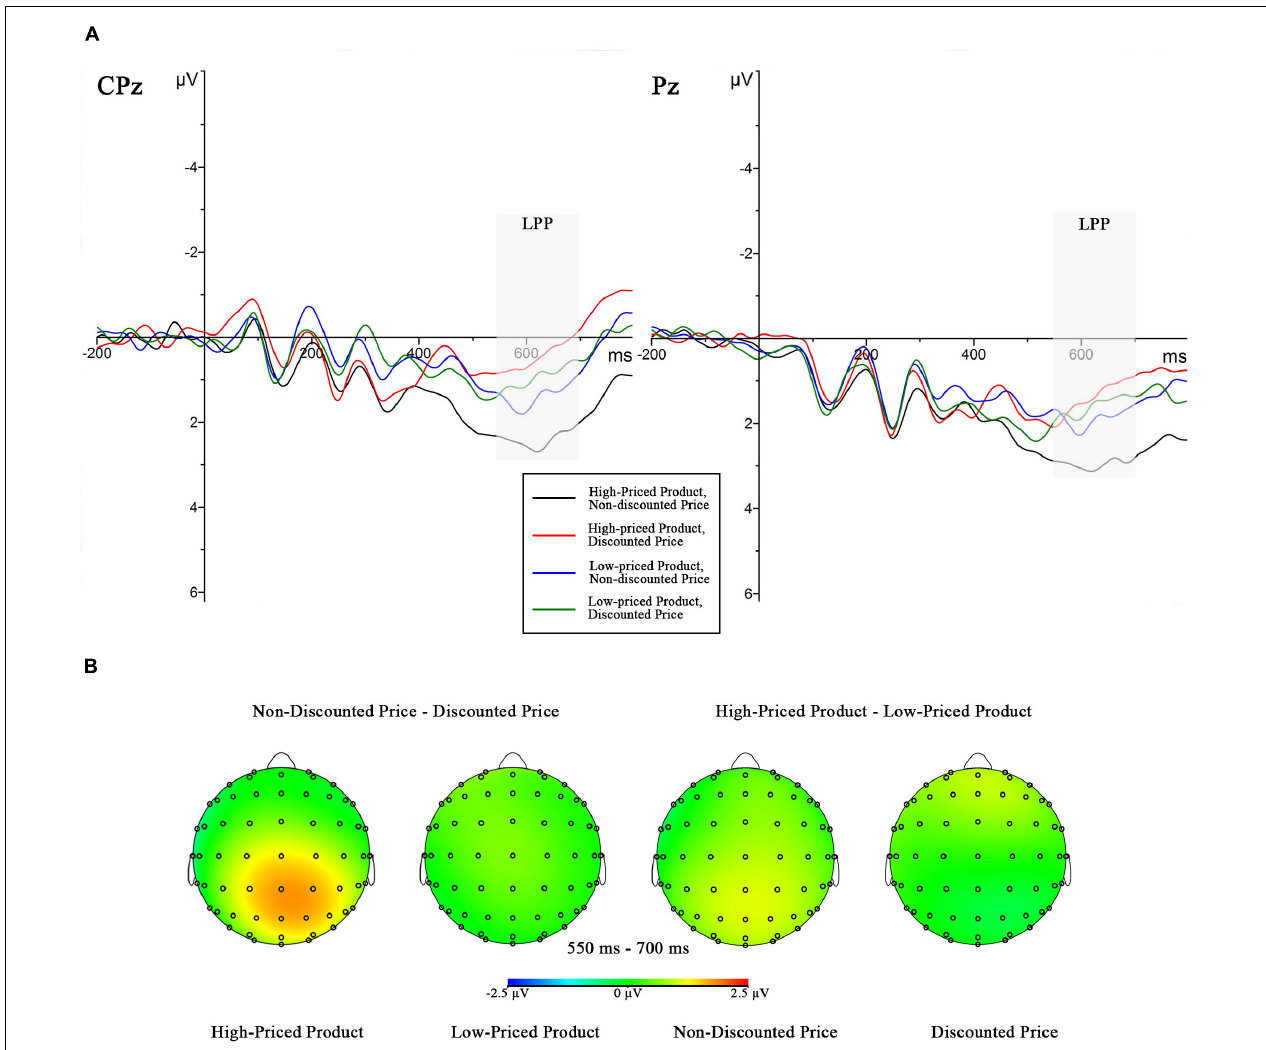
FIGURE 5 | (A) Grand-averaged ERP waveforms within the late positive potential (LPP) time window (550–700 ms) across four conditions (high-priced product with discounted price or with non-discounted price, low-priced product with discounted price or with non-discounted price) with two electrodes (CPz and Pz). (B) Difference maps corresponding to the LPP